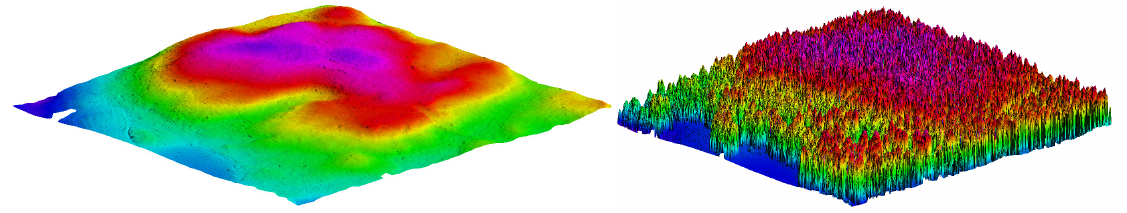
Figure 3. Examples of lidar DTM (left) and DSM